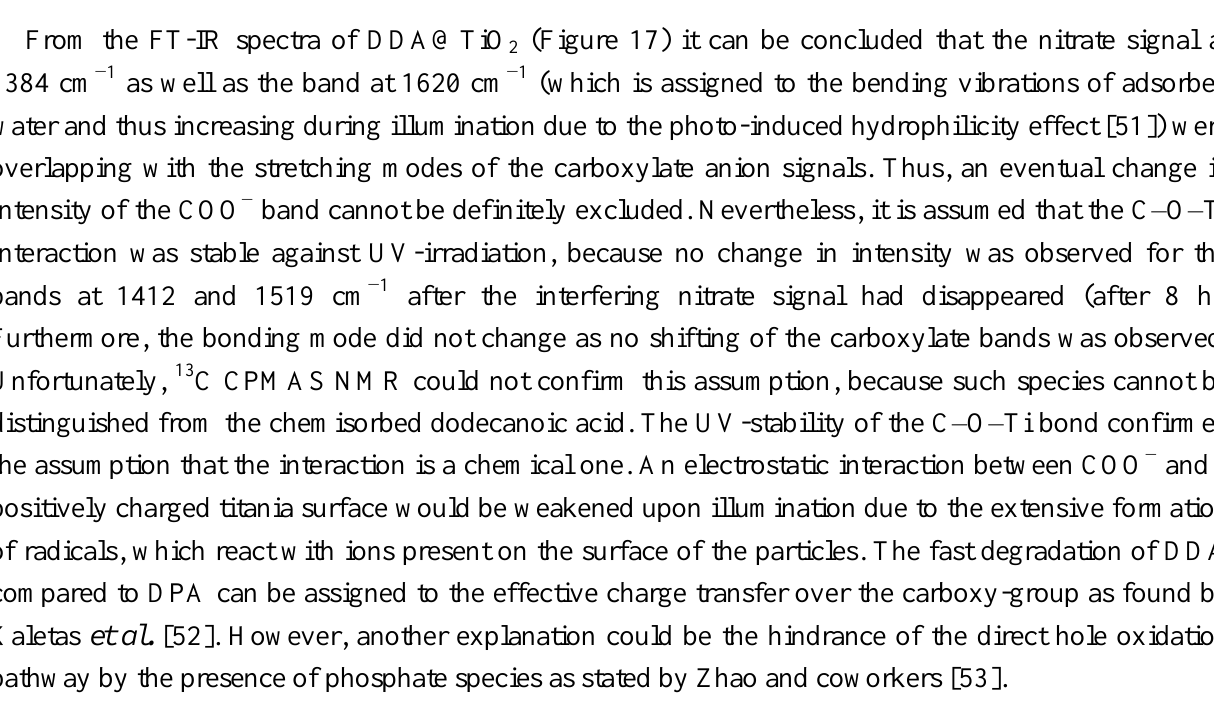
after different 2